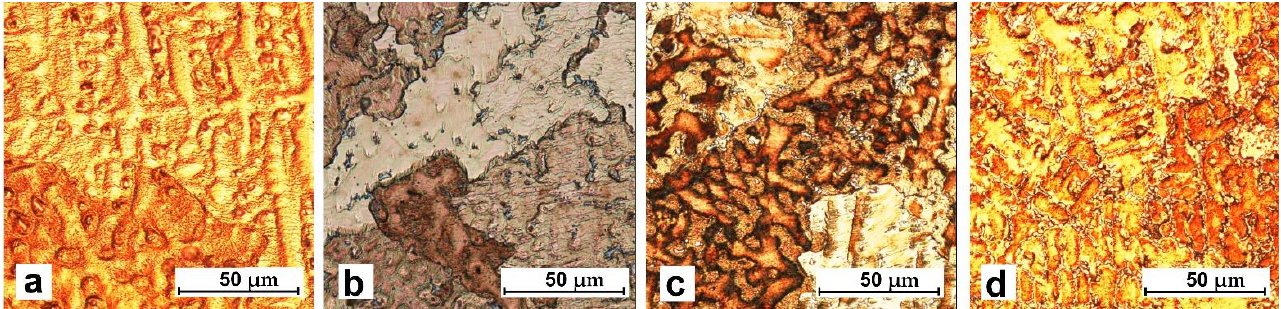
Figure 4. Microstructure of the alloy, metal mould: ( a ) CuSn8Ni3; ( b ) CuSn8Ni3Ti0.2; ( c ) CuSn8Ni3Ti0.4; ( d ) CuSn8Ni3Ti2.